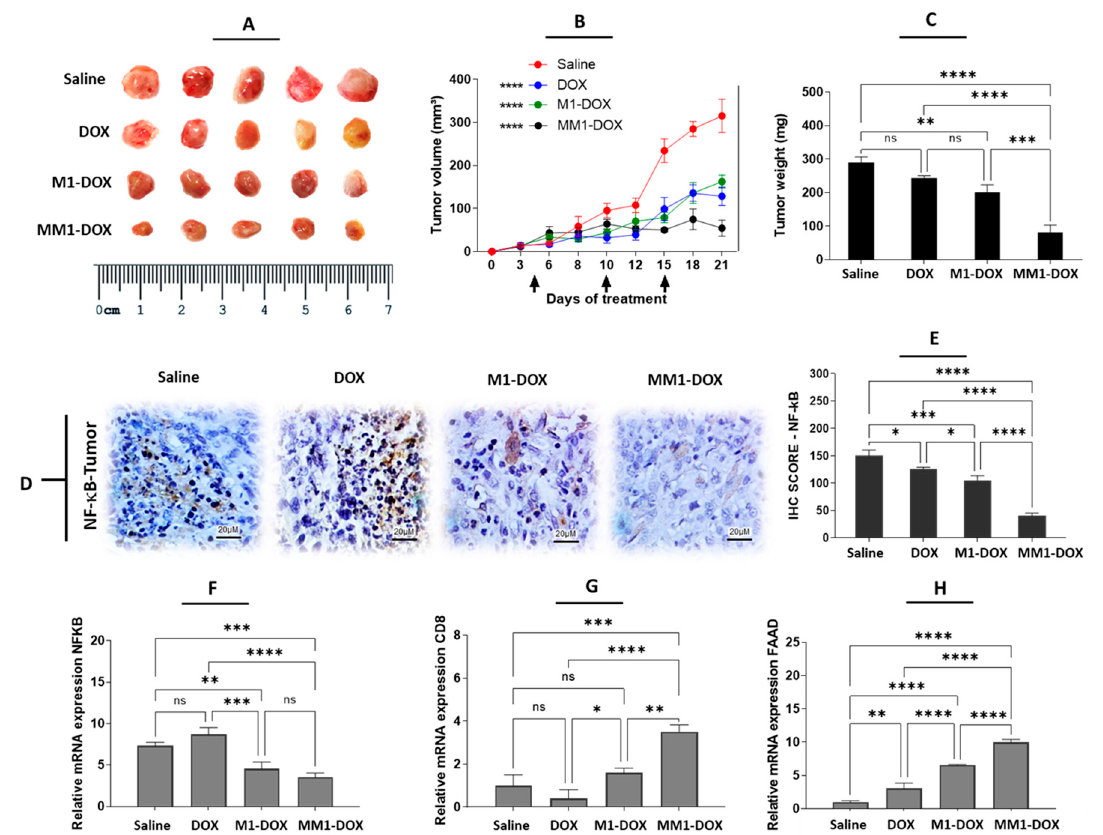
Figure 4. Influence of HA acid and CV on in vivo anticancer properties of M1-EVs loaded with DOX in an orthotopic mouse model of 4T1 pro-metastatic breast cancer. Animals were treated with saline solution (control), high dose of DOX (5 mg/kg), 2 mg/kg of M1-DOX (M1-EVs loaded with 20 µg/mL of DOX), and 2 mg/kg of MM1-DOX (MM1-EVs loaded with 20 µg/mL of DOX). ( A ) Size comparison of the tumors isolated from animals of the four experimental groups. ( B ) Tumor volume of treated animals during the 21 days of the experiment. ( C ) Tumor weight in mg of extracted tumors from animals of the four experimental groups. ( D ) Immunohistochemical (IHC) detection of NF- κ B in tumor sections from treated animals. ( E ) IHC score of NF- κ B for the four experimental groups. ( F ) Relative mRNA expression of NF- κ B, ( G ) CD8, and ( H ) FADD in tumor sections from treated animals. Data are means ± SEM ( n = 5 animals per condition). Non-significant (ns); **** p < 0.0001; *** p < 0.001; ** p < 0.01; * p < 0.05.